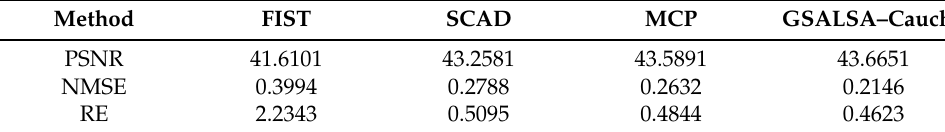
Table 8. PSNR, NMSE and RE of aircraft model under 50% sampling.